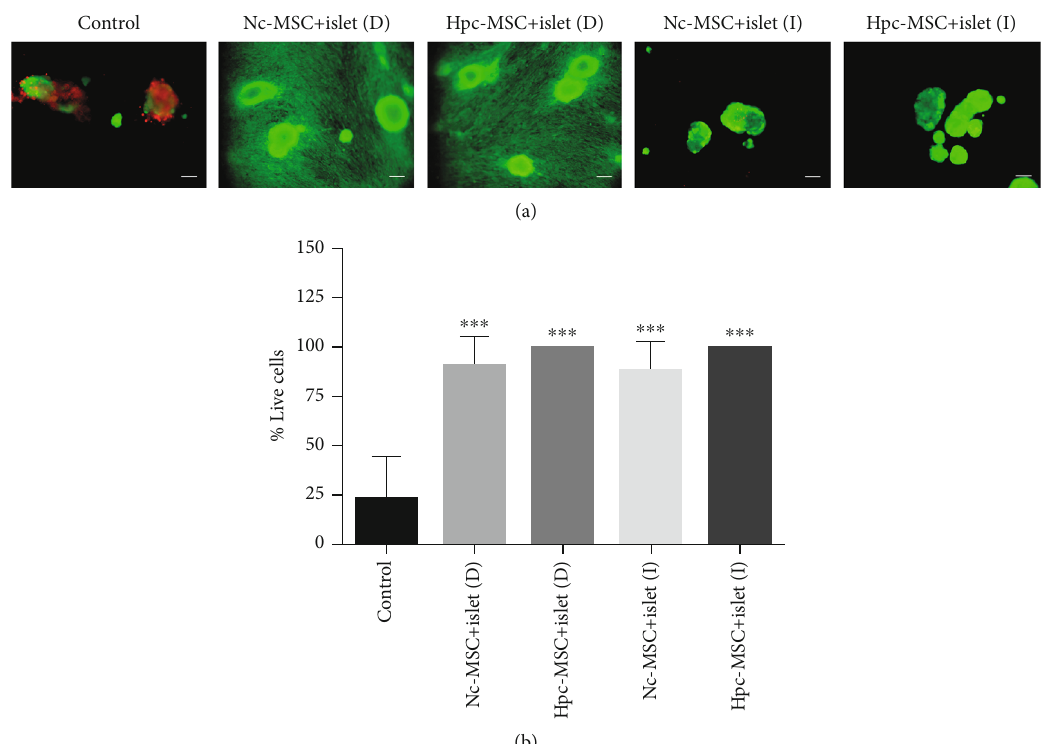
Figure 2: Human islet viability in coculture with Hpc-MSCs and Nc-MSCs. (a) Islet survival staining was done by fl uorescein diacetate (green) for living cells and propidium iodide (red) for dead cells. (b) The charts show the viability of the islet. A comparison was done between the control and each cocultured islets. Scale bar: 100 μ m, ∗∗∗ P < 0 : 001 . Nc-MSCs: normoxia condition mesenchymal stem cells; Hpc-MSCs: hypoxia preconditioning MSCs; D: direct coculture; I: indirect